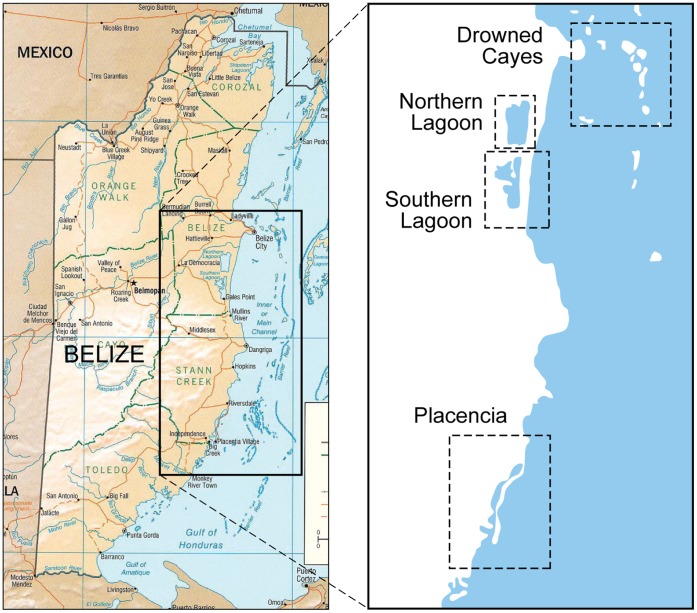
Map of four primary study sites in Belize where capture and release of free-ranging manatees occurred between 1997 and 2009.